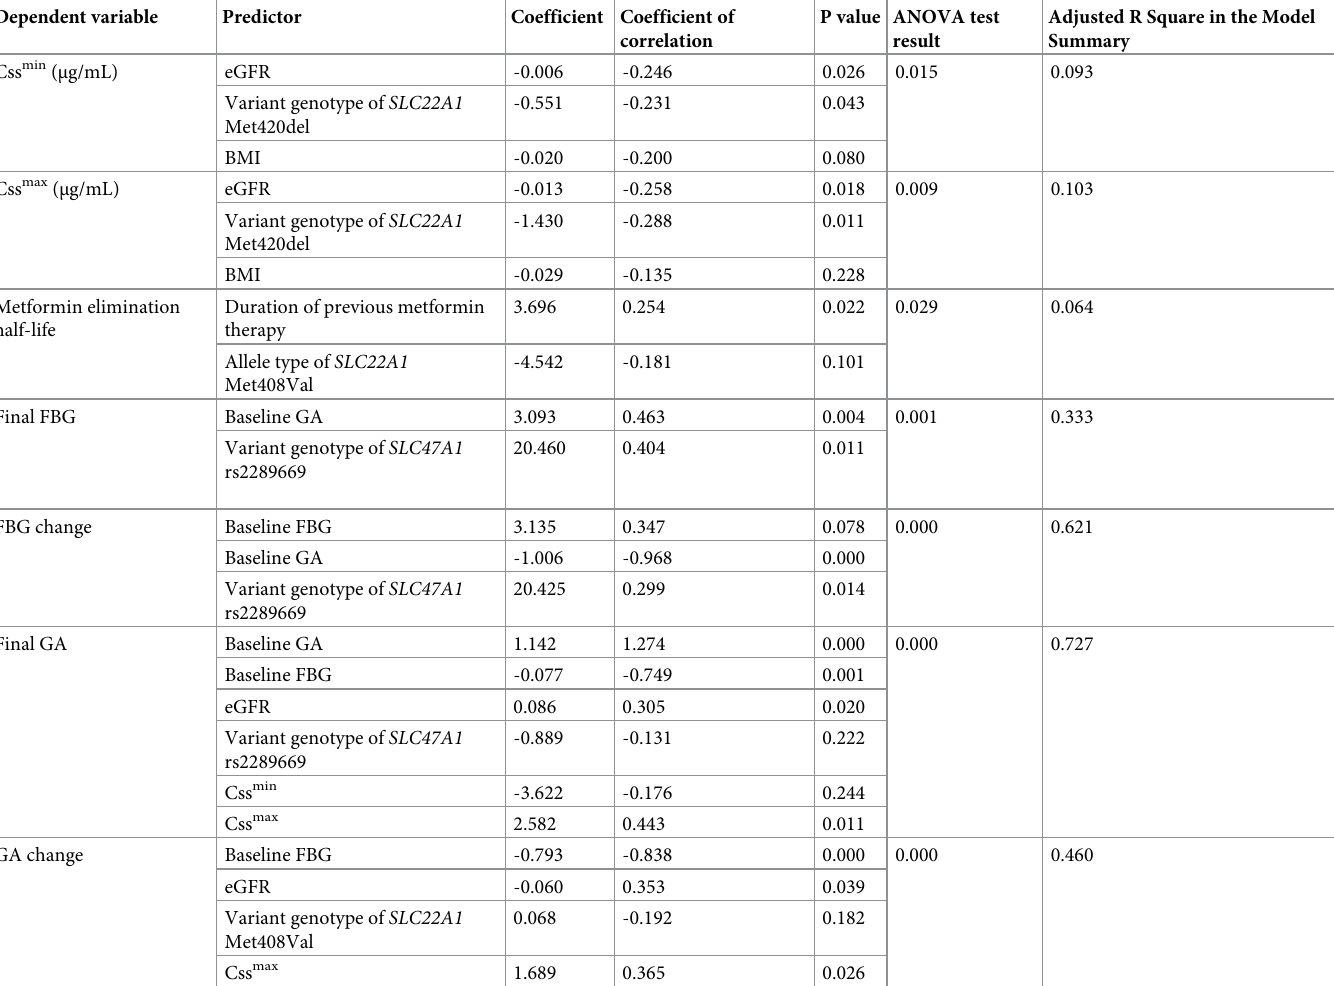
Table 3. Patient-related factors correlated with glycemic response after the administration of metformin 1000mg/day for 6